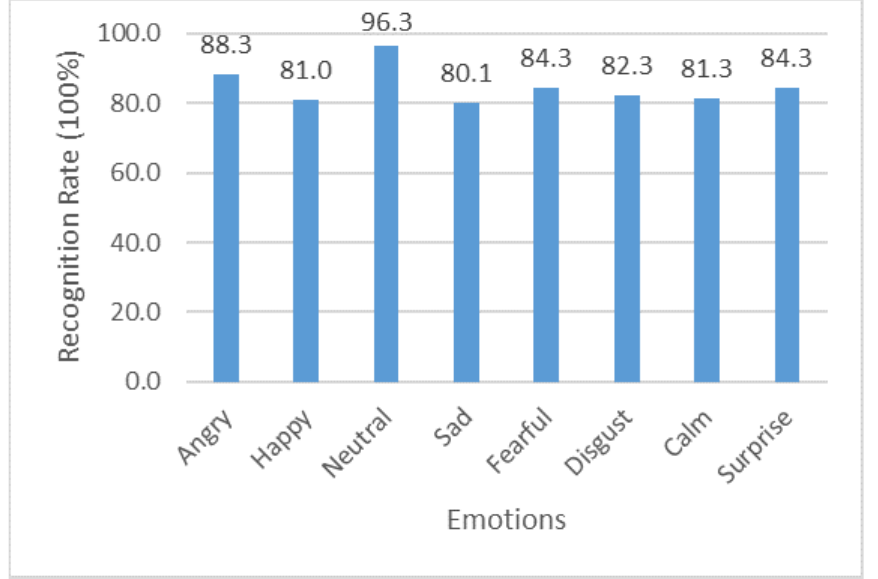
Figure 5. Emotion identification accuracy analysis of the proposed system using the RAVDESS dataset.